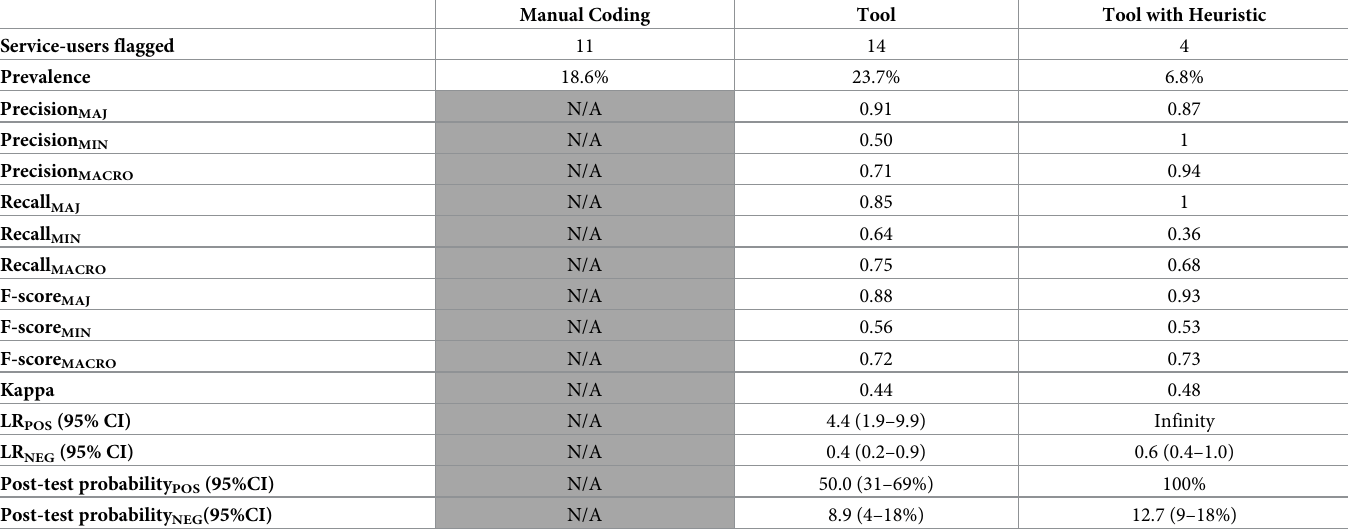
Table 4. Service-user-level evaluation results on the test set (N = 59 service-users).